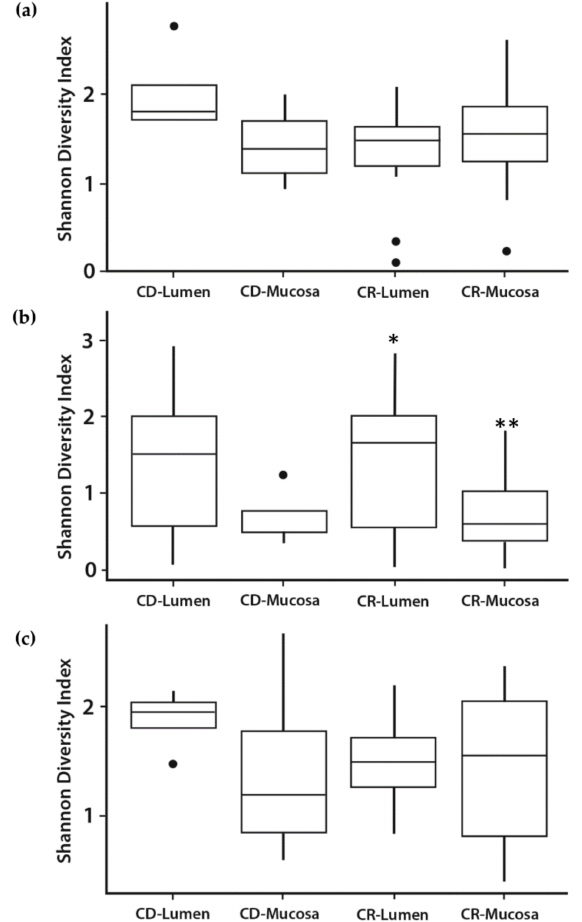
Figure 3. Shannon diversity indices of microbial communities were calculated for each sample, within each tissue, using the package ‘vegan’, version 2.4-5. Shannon diversity indices in the lumen and mucosa of three major intestinal tissues, cecum ( a ), ileum ( b ), and spiral colon ( c ) in calves not fed colostrum, CD = colostrum deprived, and calves fed colostrum, CR = colostrum replacer. Closed circles, • , represent outliers. Di ff erent superscripts are statistically di ff erent: Ileum, CR-Lumen versus CR-Mucosa, *,** p <